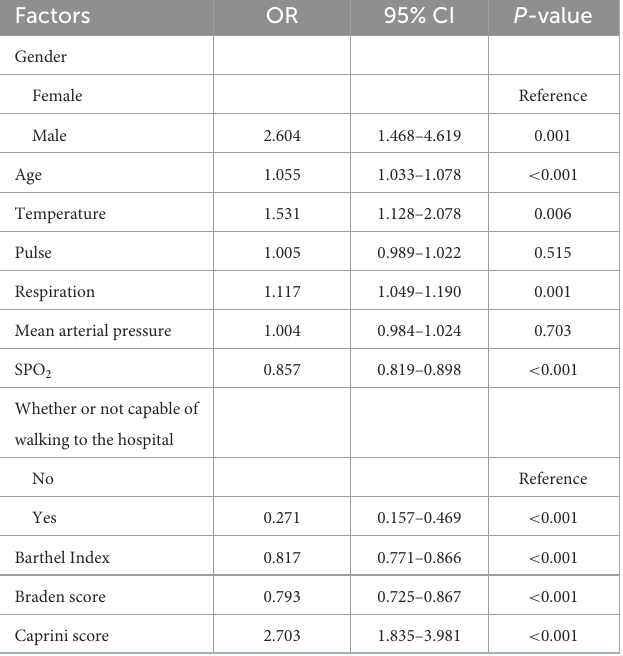
TABLE 2 Univariate logistic regression analysis of the association between the factors and the prognosis of the patients. Factors